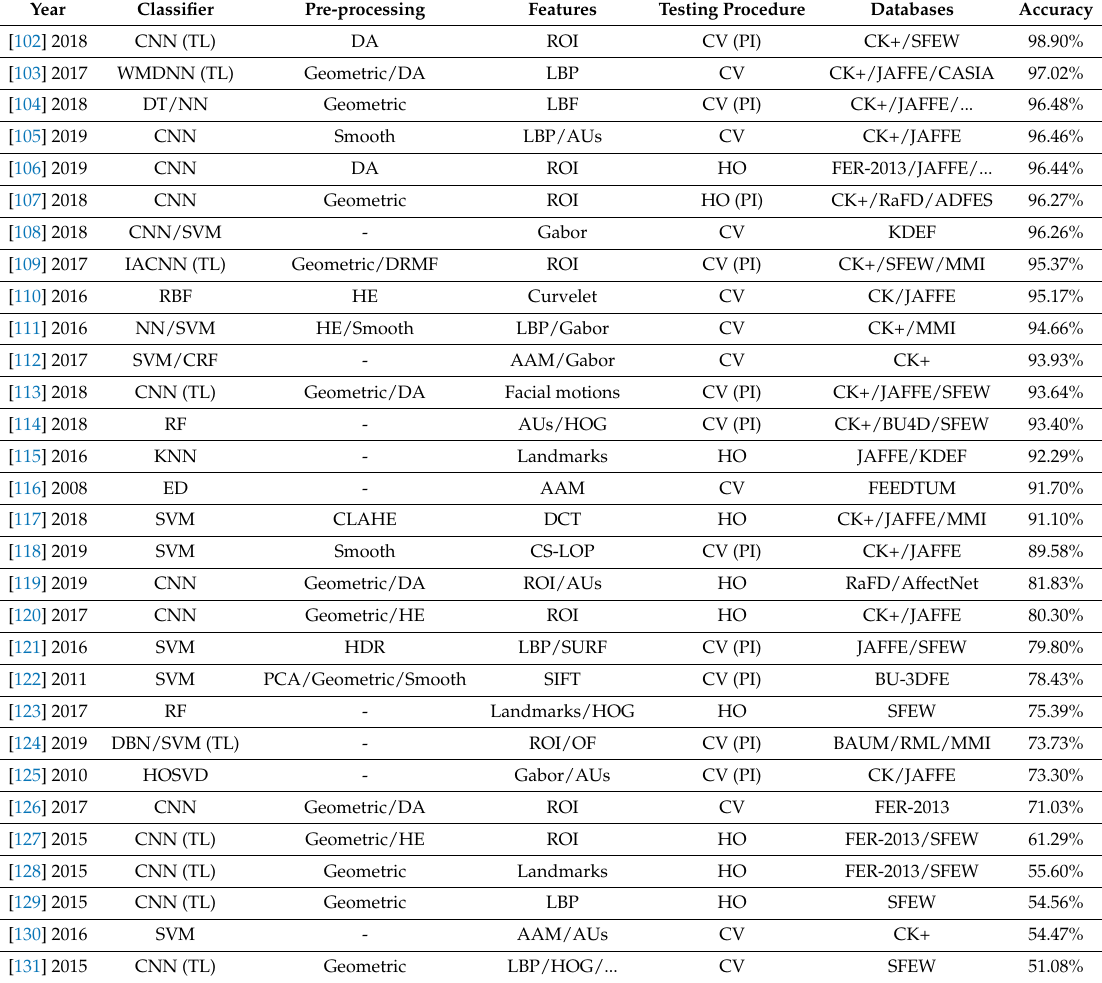
Table 2. Results of reviewed works for static image